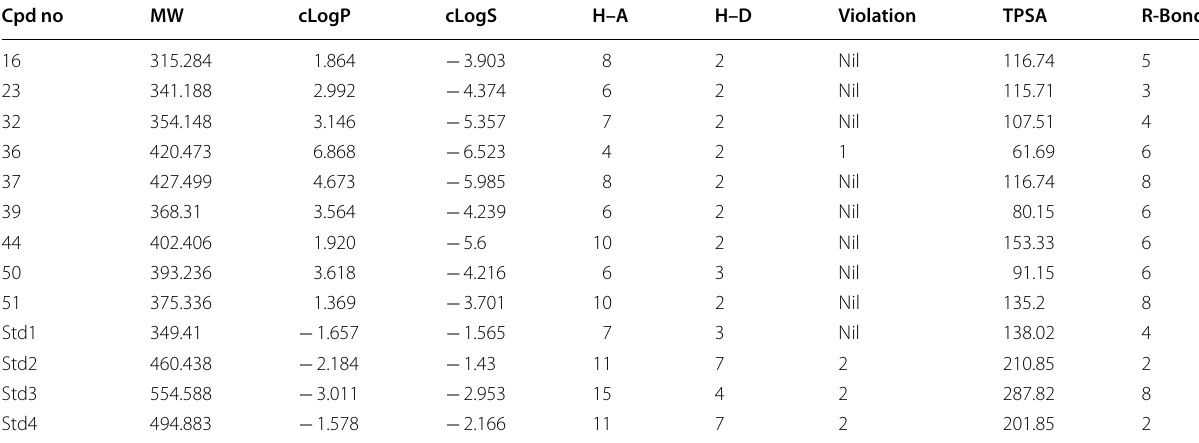
Table 6 Physicochemical properties of selected compounds in comparison with standard drugs